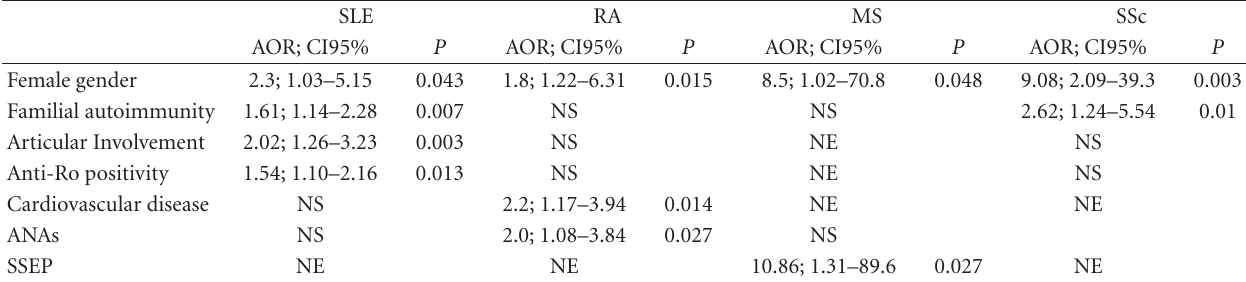
Table 2: Significant factors associated with